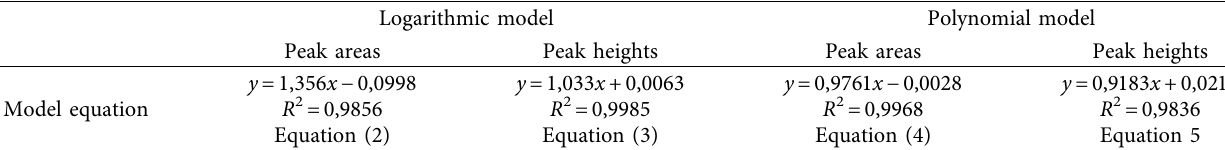
Figure 3: Chromatographic profile of the solution containing sildenafil and tadalafil. Table 6: Equations of the overlap